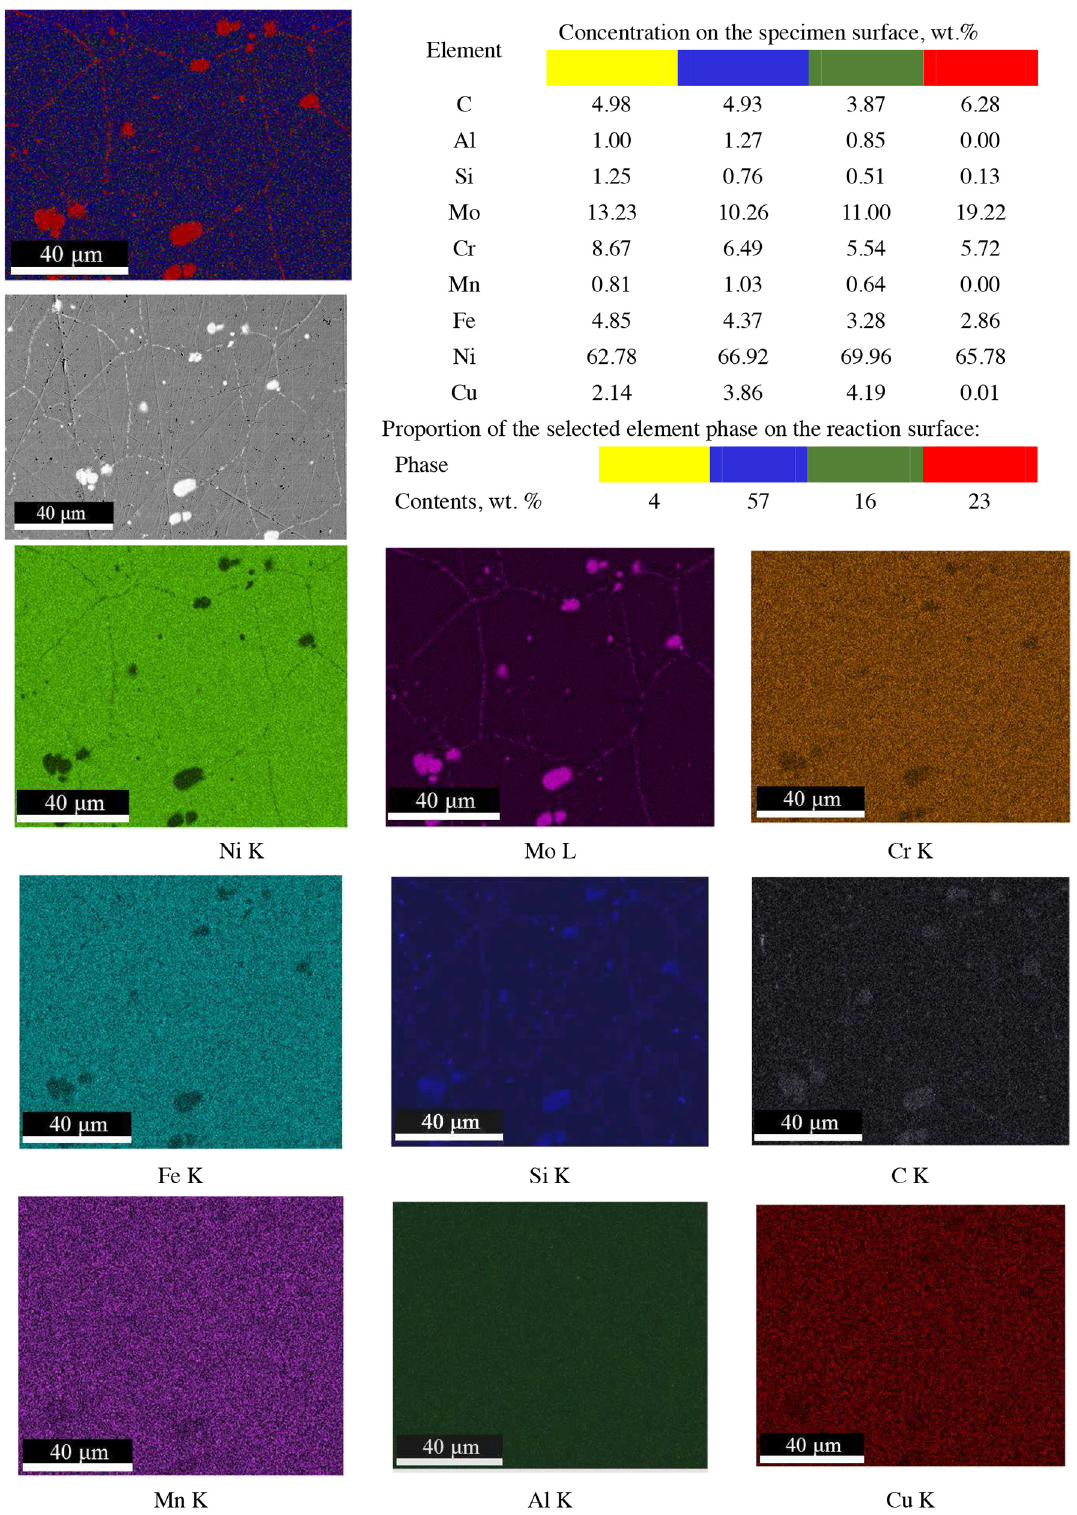
Fig. 4. MPCA metallographic structure and element composition data for different surface areas of the Hastelloy-N alloy after annealing at 800 °